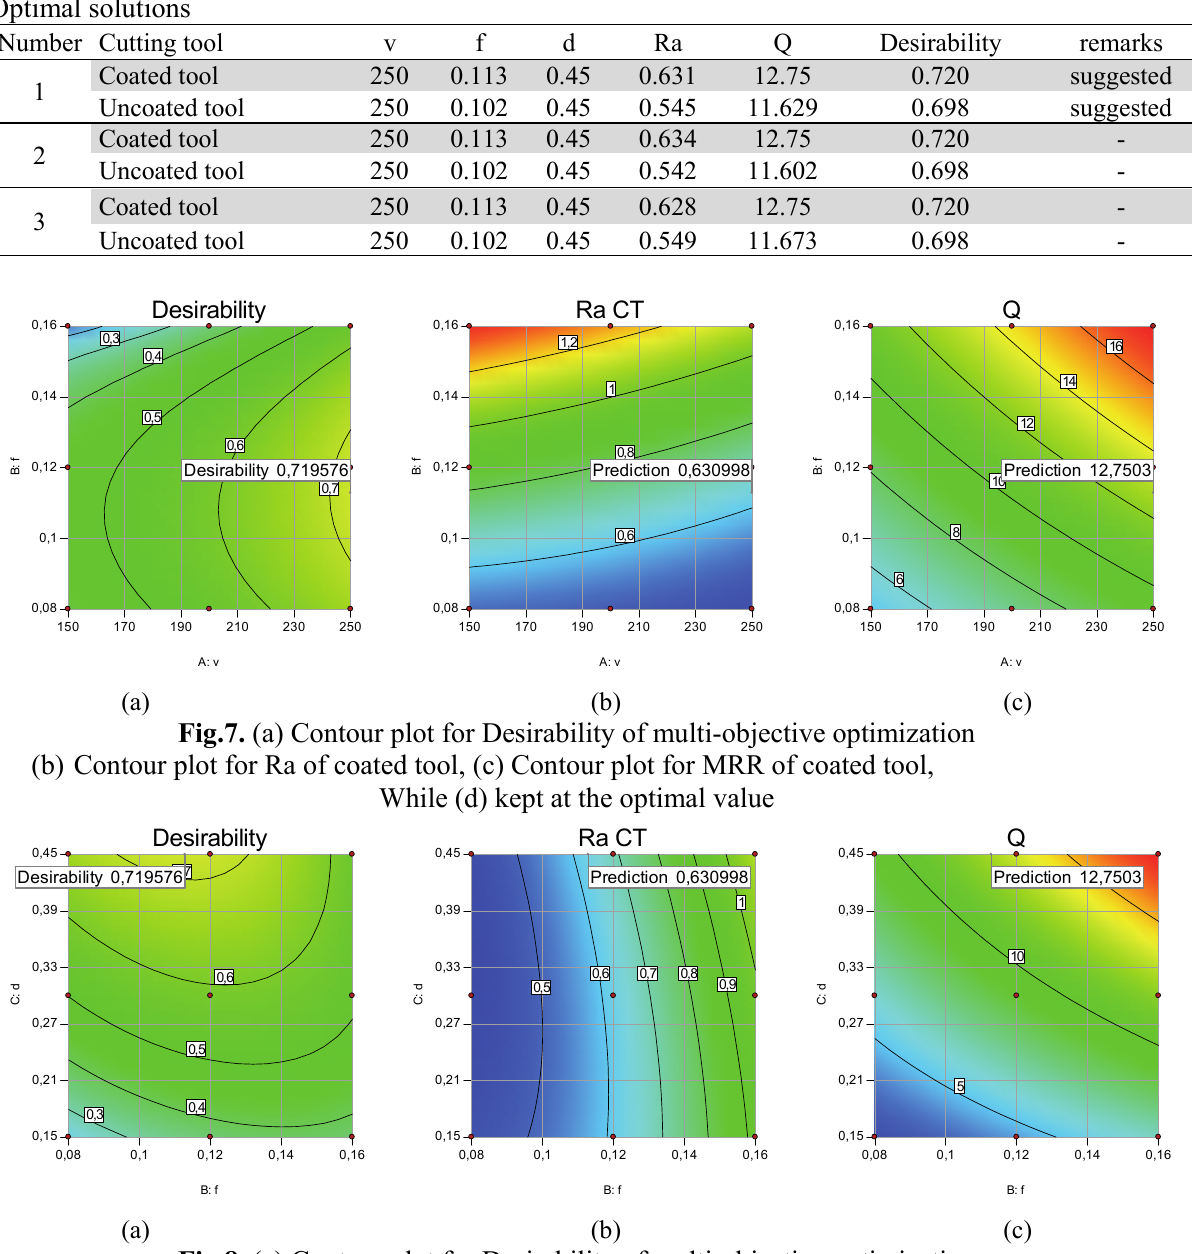
Fig.8. (a) Contour plot for Desirability of multi-objective optimization (b) Contour plot for Ra of coated tool, (c) Contour plot for MRR of coated tool while (V) kept at the optimal